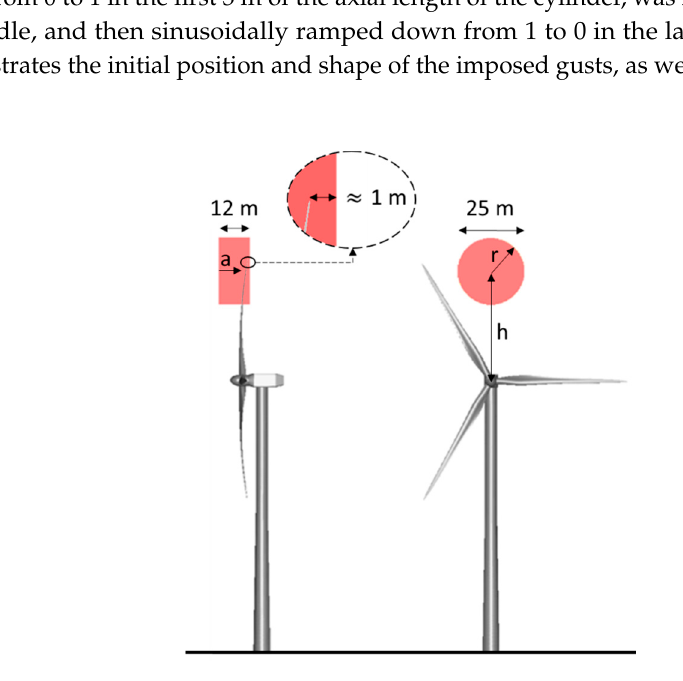
Figure 4. ( left ) Side view with detail of the blade tip axial position relative to the gusted region and ( right ) front view of the initial position and shape of the imposed gusts (in red) with respect to the wind turbine.